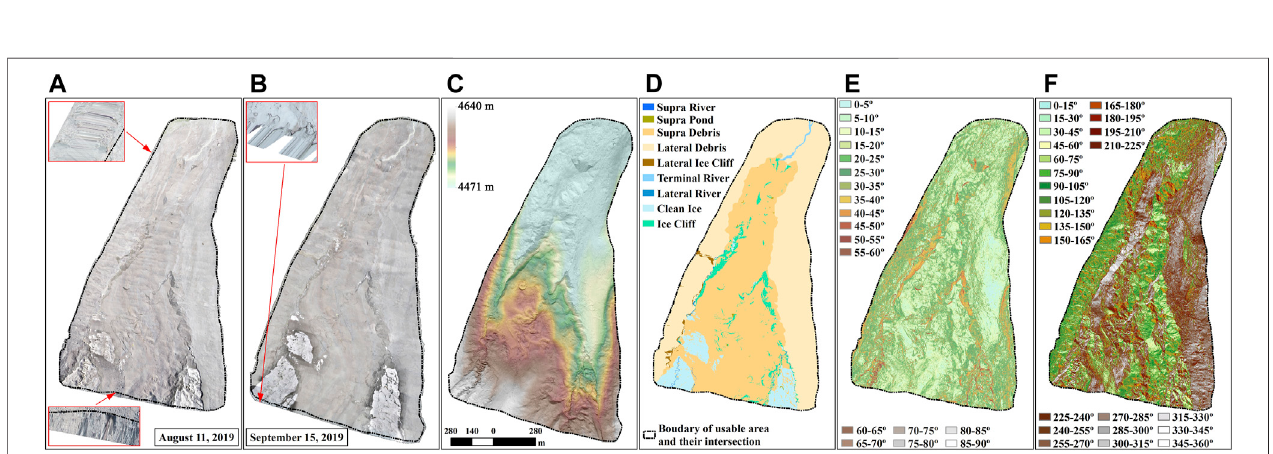
FIGURE3| ThemosaickedUAVimagesonAugust11 (A) andSeptember15 (B) ,andtheshadedDSM (C) ,vectorizedandmanuallymodi fi edsurfaceclassi fi cation (D) , slope (E) , and aspect (F) classes, all from image and DSM on September 15. Insets in A and B show the artifacts exist along the edges of the UAV surveyed region which were excluded from the studied area by the manually digitized boundaries (dash-dot lines).